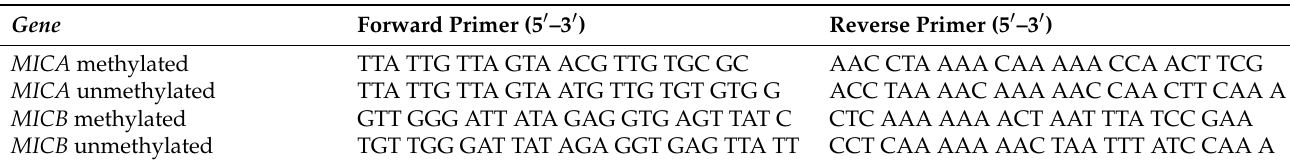
Table 2. List of MSPCR